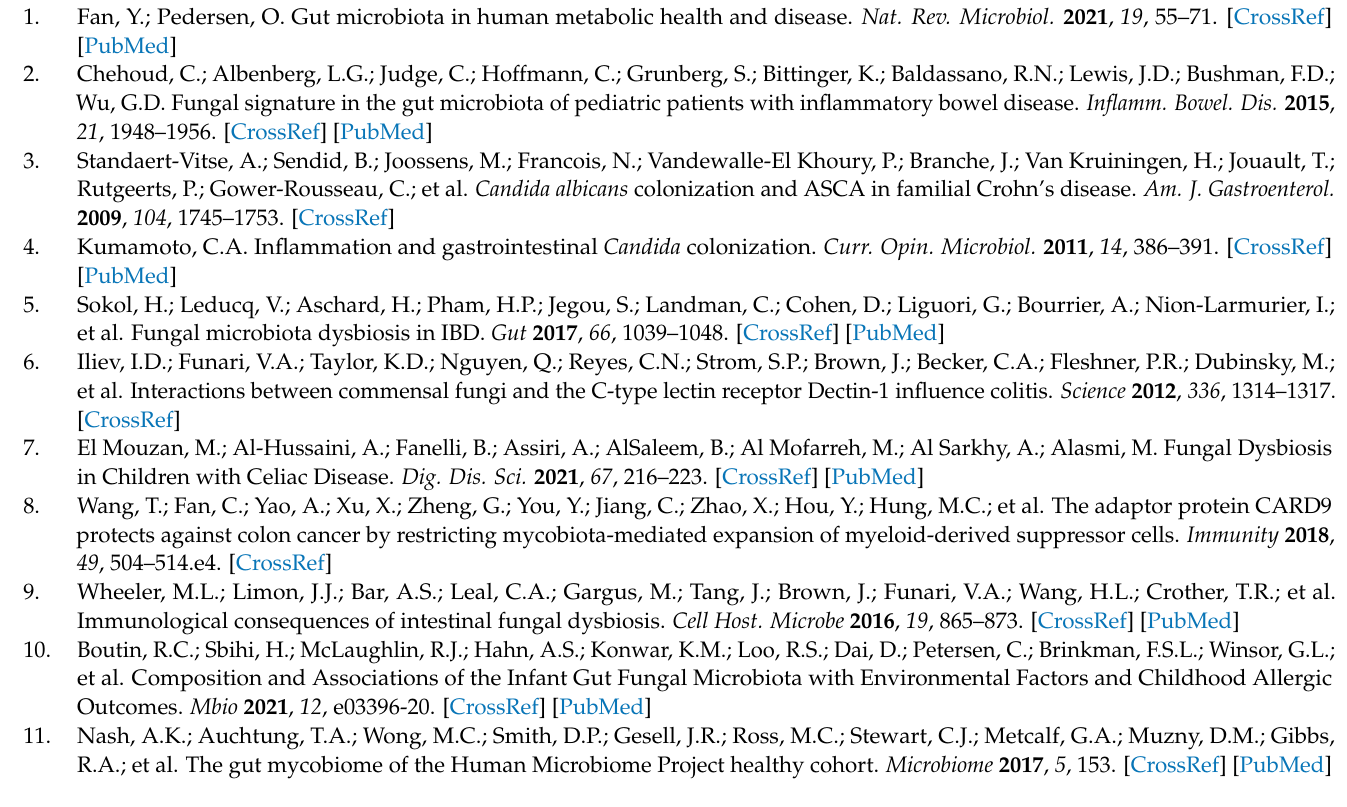
Supplementary Figure S3. Interkingdom correlations at genus level at four different timepoints after start of antibiotics or after first sample stratified by the group that remained antibiotic-naïve and the group that received antibiotics during the study. AB = antibiotics. Supplementary Figure S4. Interkingdom correlations at genus level at 1–2 weeks after starting antibiotic treatment. There were no samples collected from the antibiotic-naïve patients at this timepoint. AB =